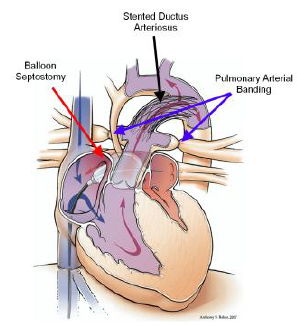
FIGURE I: The Hybrid